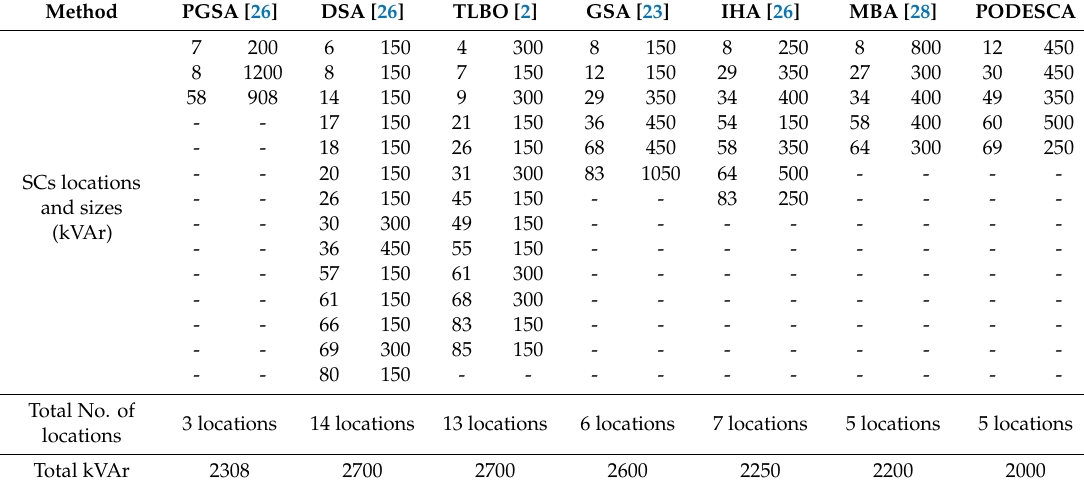
Table 7. Optimal locations and sizes of SCs by PODESCA comparing to other methods for the 85-bus system.